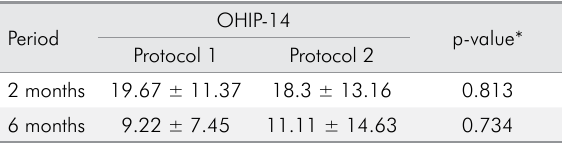
Table 7. Mean and standard deviation for OHIP-14 quality of life questionnaire values for both ERAS group (Protocol 1) and control group (Protocol